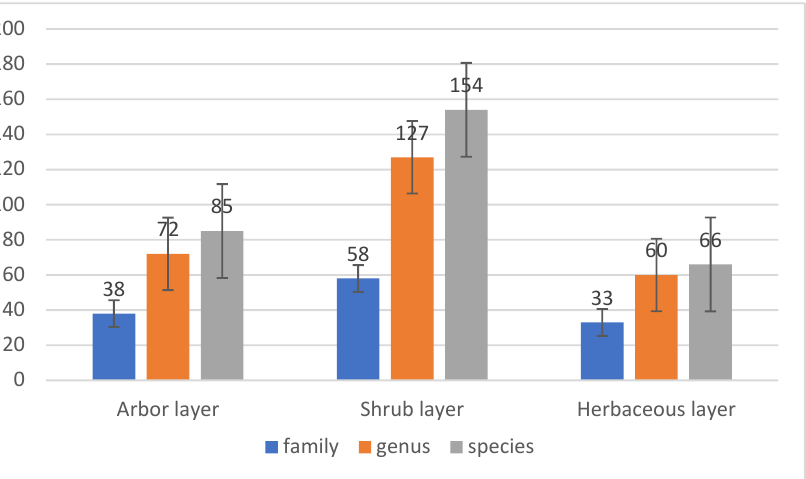
Figure 5. Vertical structure of the samples with rare and endangered plants in the Sanya River Basin, Hainan Province, China.